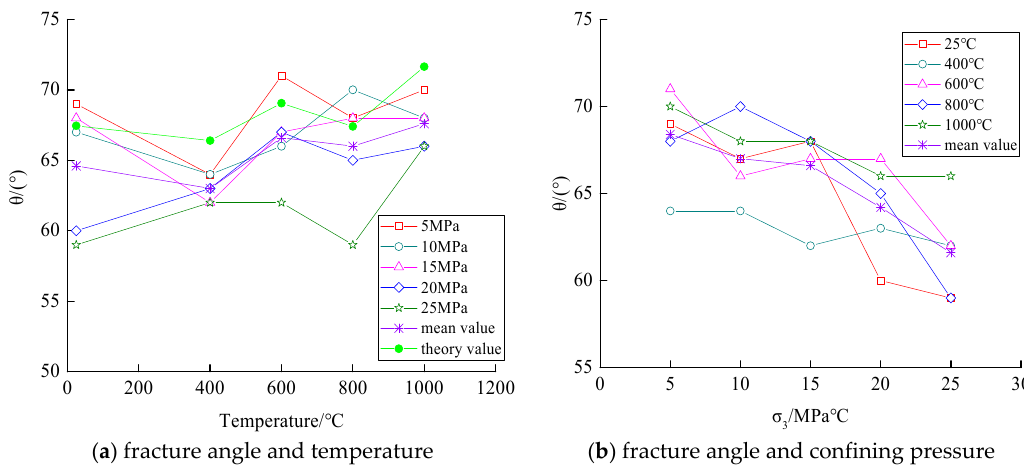
Figure 17. Relationship between three axis strength and confining pressure and temperature after high temperature. high